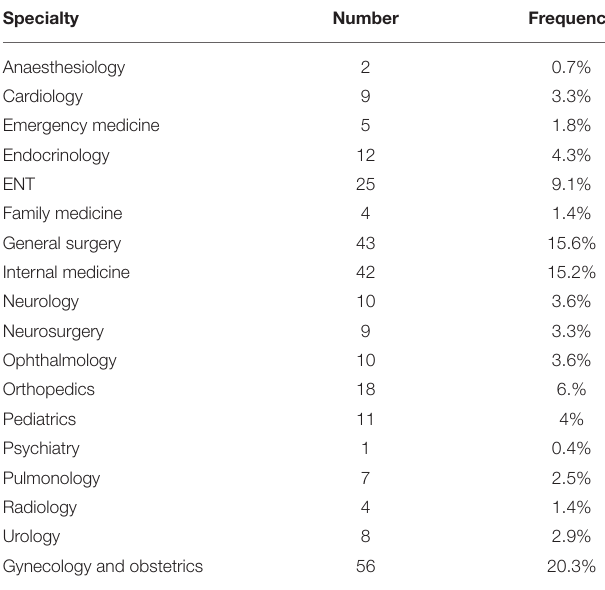
TABLE 1 | Baseline characteristics of the study sample ( N = 276). TABLE 2 | Summary of specialties in study sample ( N =